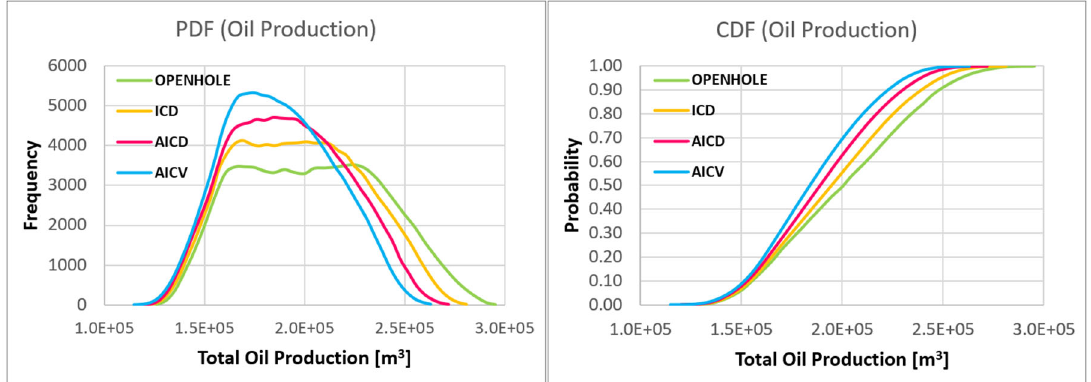
Figure 14. Probability and cumulative distribution function for oil production after 10 years.